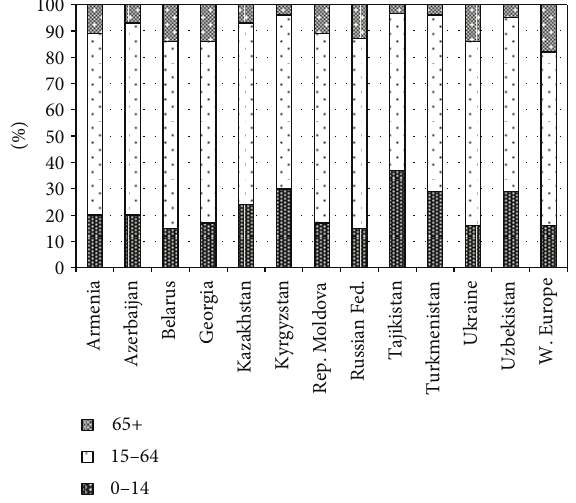
F 3: Age structure of population in CIS and Western European Countries, 2010. Note: W. (Western) Europe: Austria, Belgium, France, Germany, Liechtenstein non-EU member) (source: [16]). ∗